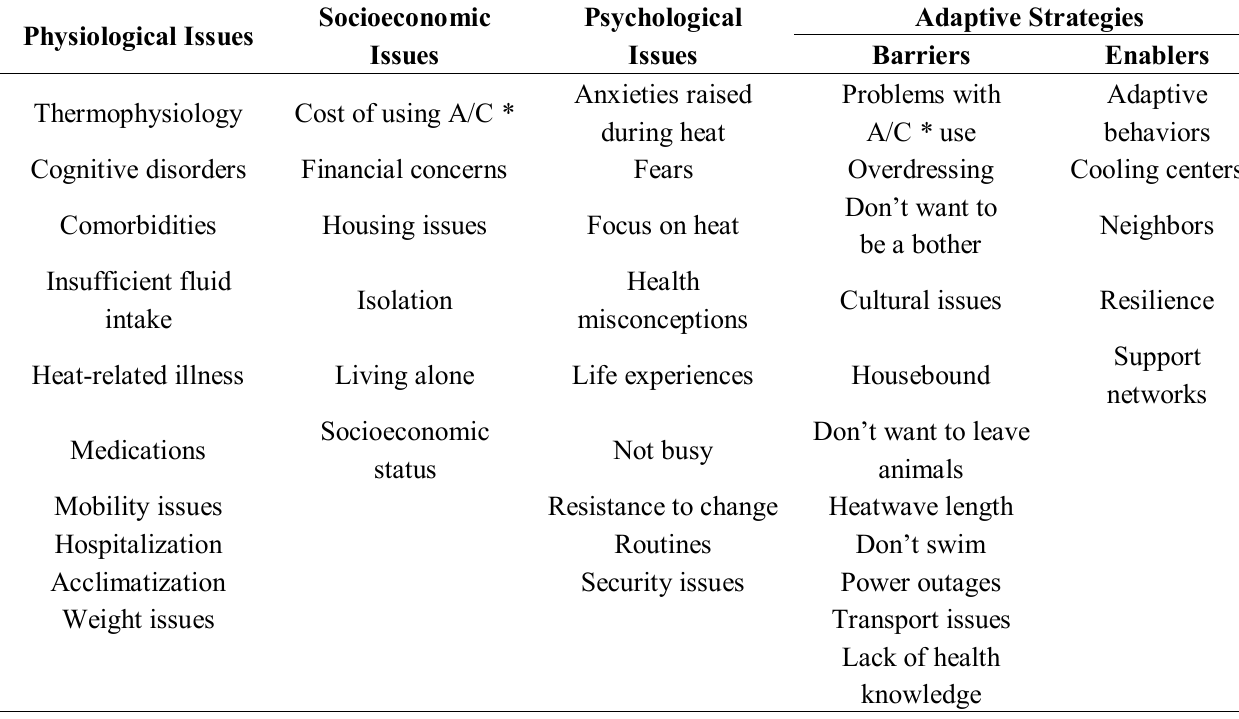
Table 2. Identified codes assigned to the four main